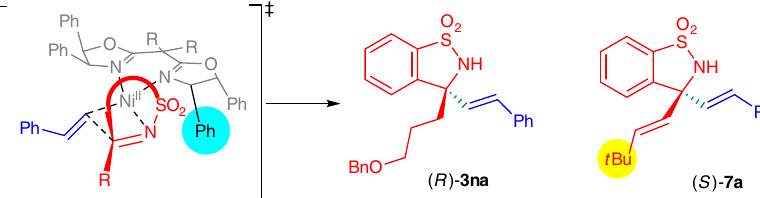
Fig. 4 Model for explaining the origin of asymmetric induction. The alkenyl attacks the C = N bond from the Re -face to generate the products ( R )- 3na or ( S )-